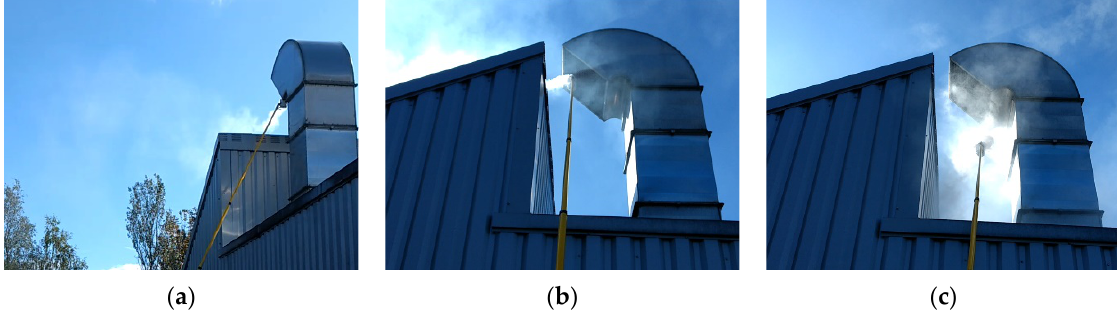
Figure 3. ( a , b ) Example of the dispersion of smoke discharged in the upper part and ( c ) in the lower part of the air flow at the stack outlet, under identical meteorological conditions.